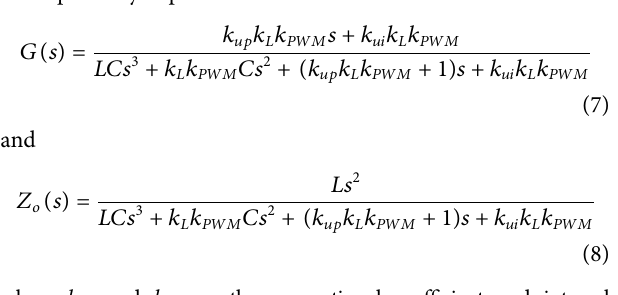
FIGURE 6 | Block diagram of the observer.